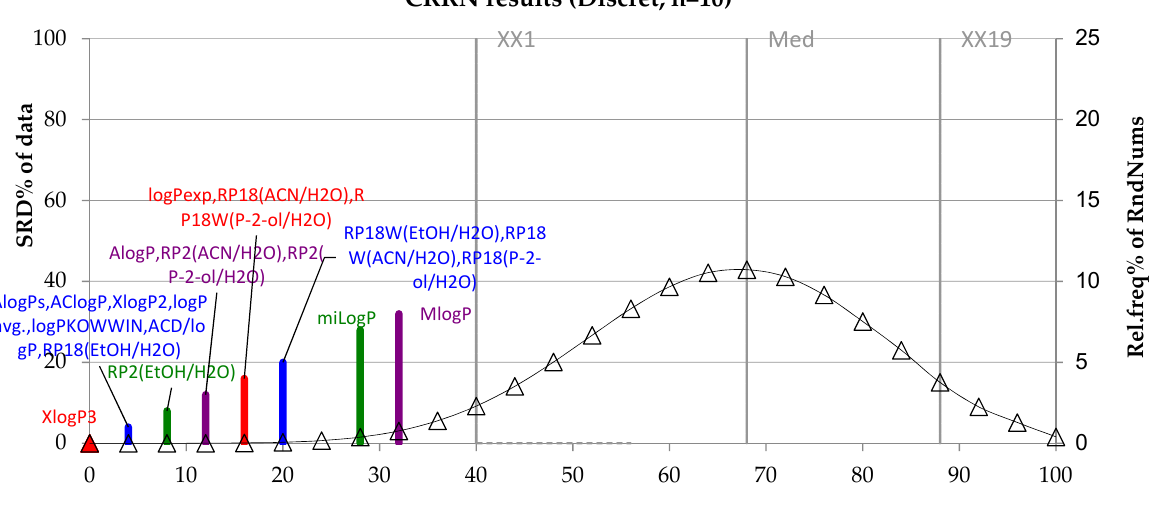
Figure 5. SRD analysis for theoretically and experimentally obtained values of lipophilicity for compounds investigated.